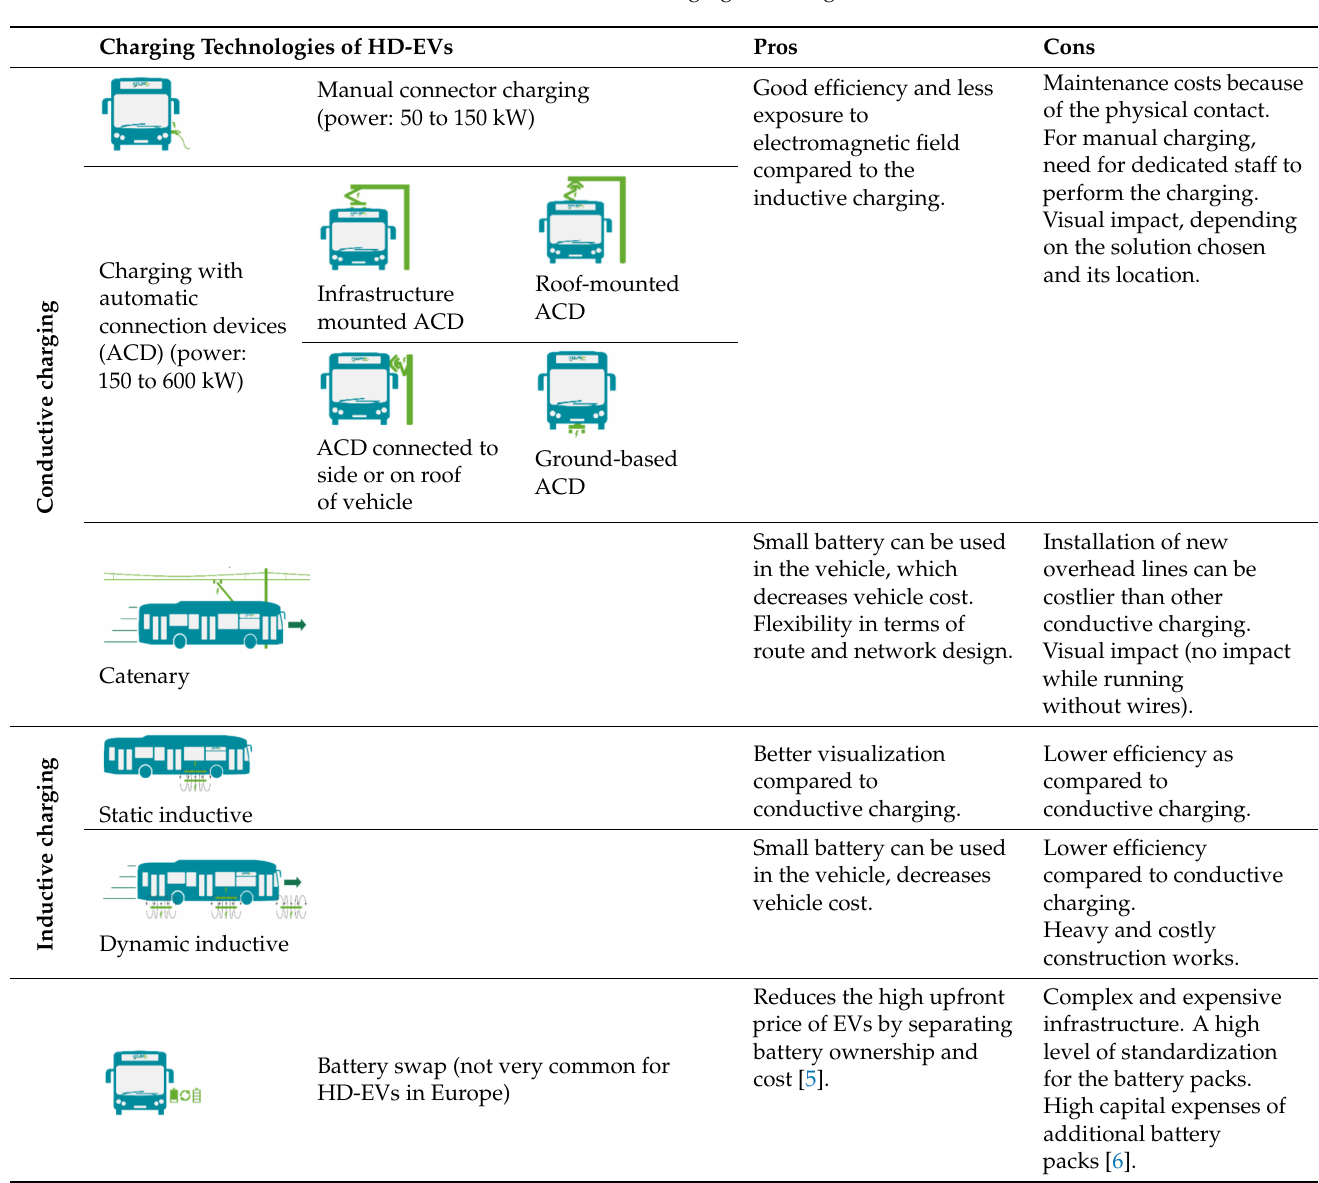
Table 1. Overview of available charging technologies for